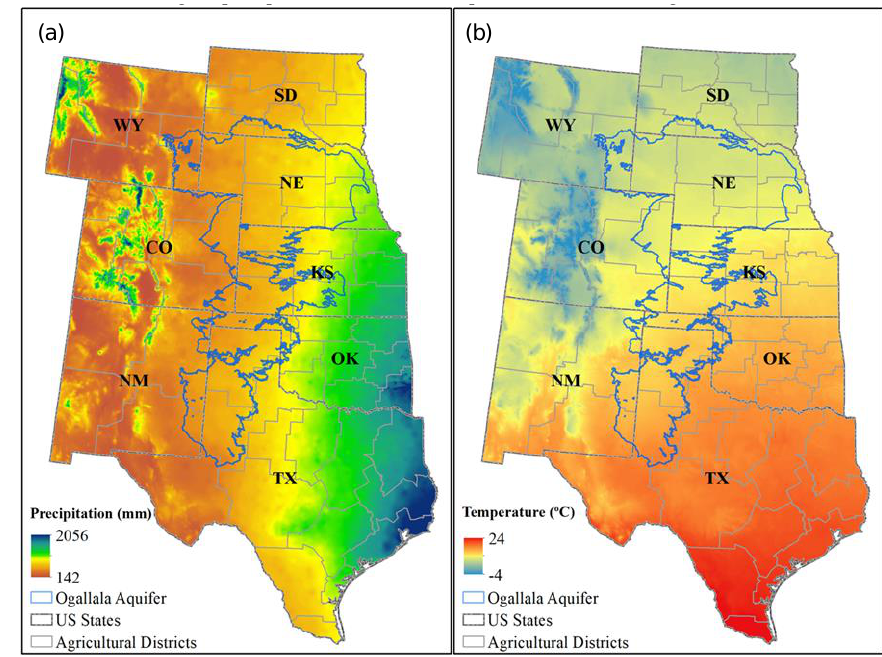
Figure 2. Mean annual average total precipitation showing an increasing east-west gradient ( a ) and mean annual temperature showing an increasing north-south gradient ( b ). Data obtained from [23].